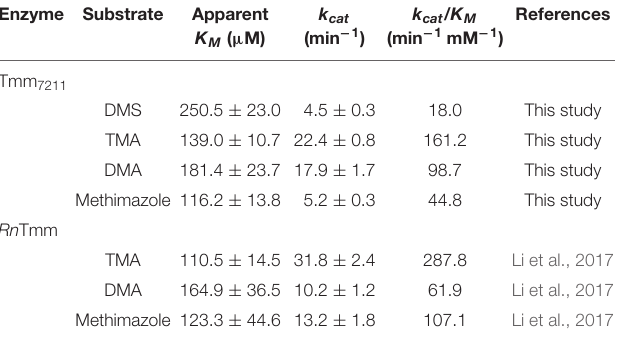
TABLE 1 | Kinetic parameters for Tmm 7211 and Rn Tmm. Enzyme Substrate